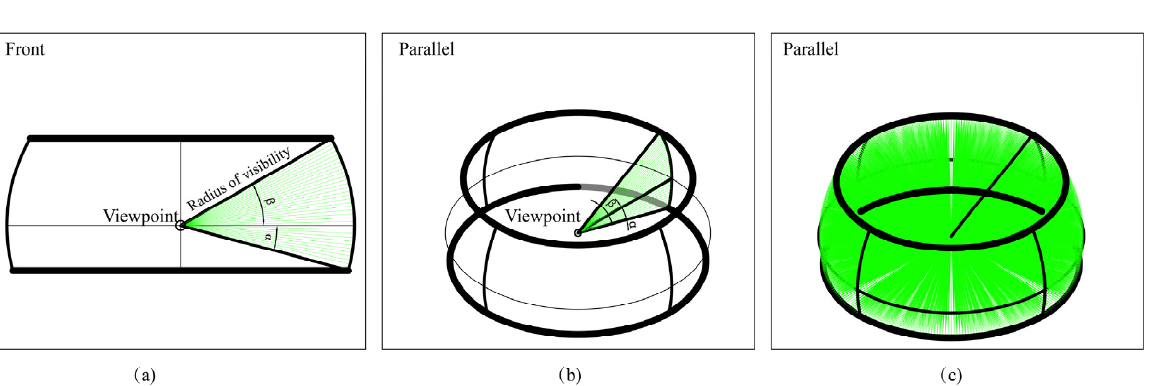
Figure 2. A 3D isovist line-of-sight composition structure, ( a ) generating a vertical 2D sectoral line- of-sight composition structure from the viewpoint, ( b ) a horizontal circular array centered on the viewpoint, ( c ) a 3D isovist originating from a viewpoint.